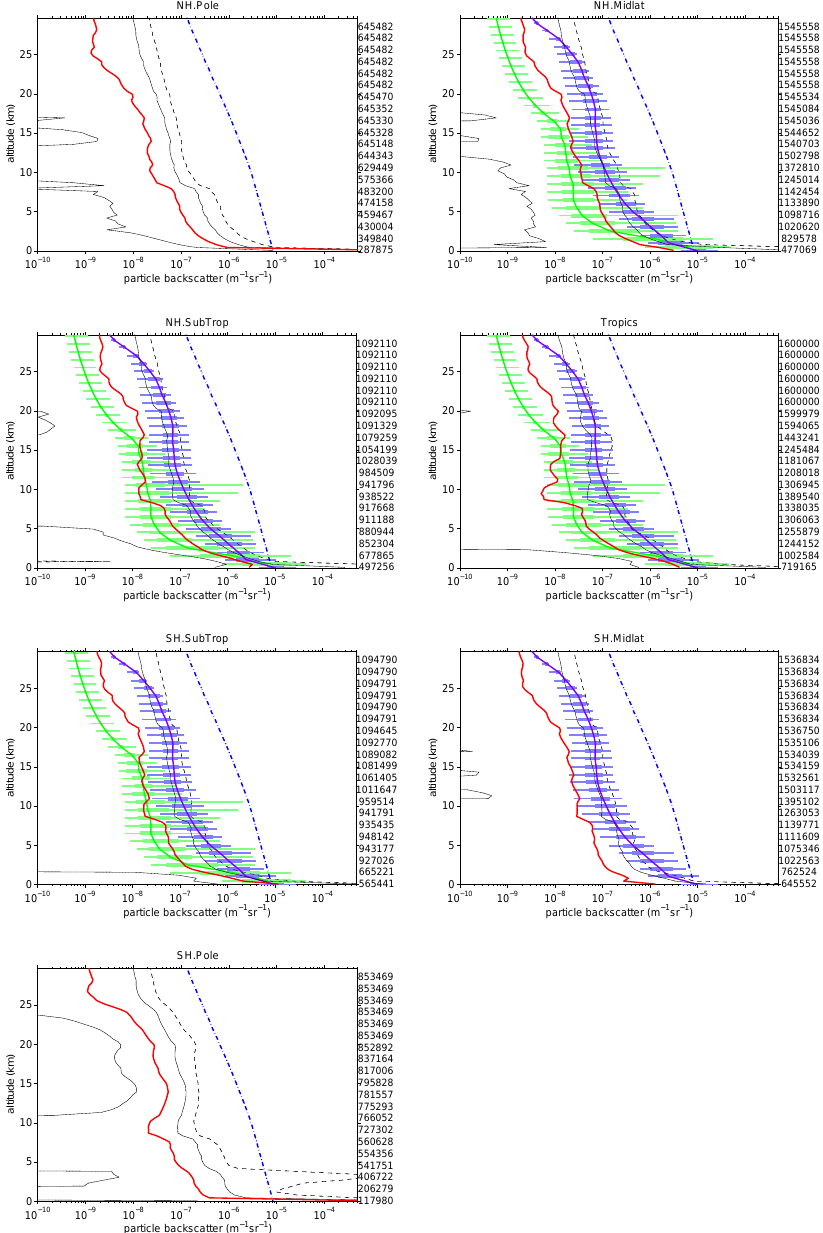
Fig. 7. Backscatter statistics at 355nm wavelength as a function of climate zones for the whole month of January 2007. The red and black curves correspond to one month of retrieved backscatter data from CALIPSO; the red line denotes the median, the black solid lines denote the 25% and 75% percentiles, the black dashed line denotes the 90% percentile. The green solid line denotes the reference model atmosphere (RMA) median profile, see the text for details. The purple solid line corresponds to the median backscatter obtained from LITE. The bars correspond to the 10–25%, 25–75% and 75–90% percentiles. The dash-dotted blue line shows molecular backscatter for reference. The numbers on the right hand side of the figure show the number of data used for the CALIPSO aerosol